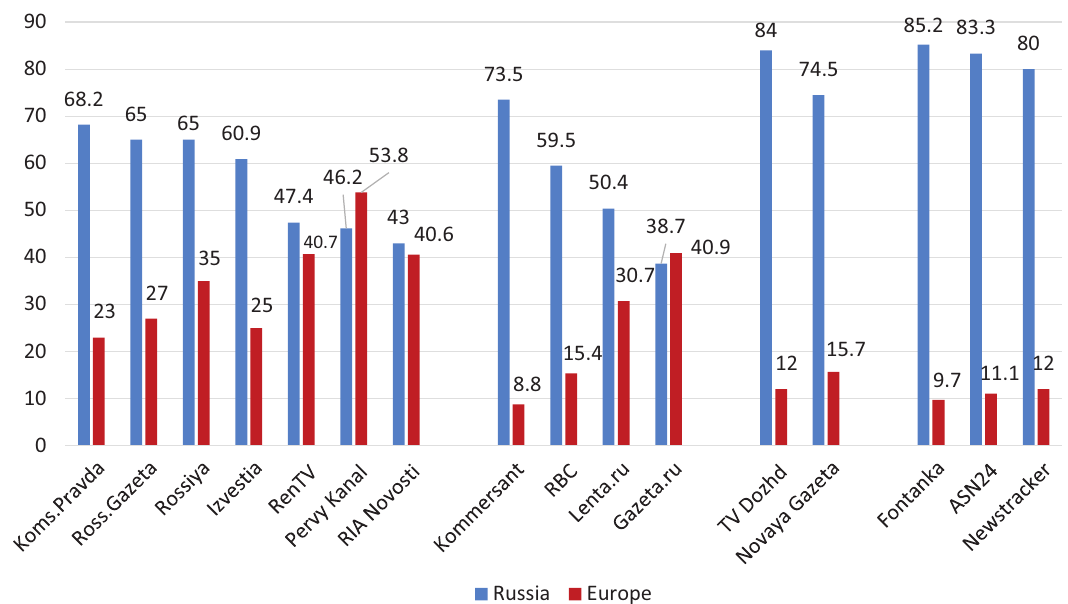
Figure 3. Percentages of publications dedicated to immigrants into Russia and Europe. Notes: The four groups (left to right) = pro‐state outlets, neutral business/online dailies, liberal‐oppositional media, and regional media; Koms.Pravda = Komsomolskaya Pravda ; Ross.Gazeta = Rossiyskaya Gazeta